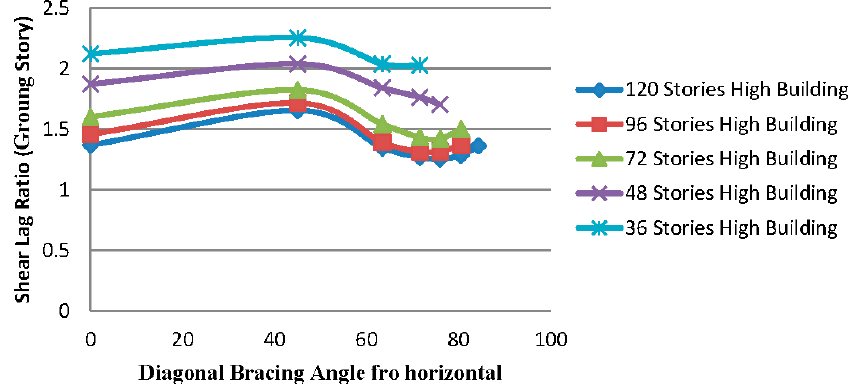
Figure 14. Variation of shear lag ratio with varying angle of bracing system for buildings of Model